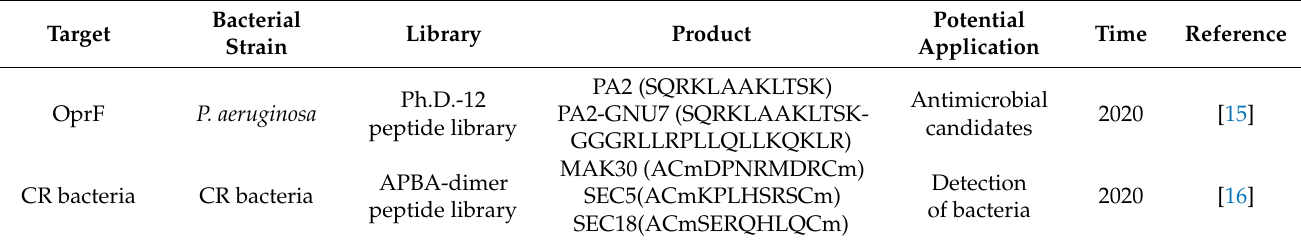
Table 1. Application of peptide phage display technology in antibacterial